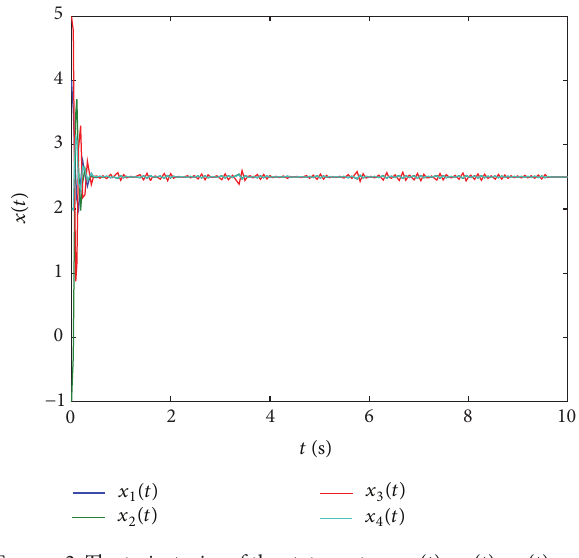
Figure 2: The trajectories of the state vectors 𝑥 1 (𝑡) , 𝑥 2 (𝑡) , 𝑥 3 (𝑡) , and 𝑥